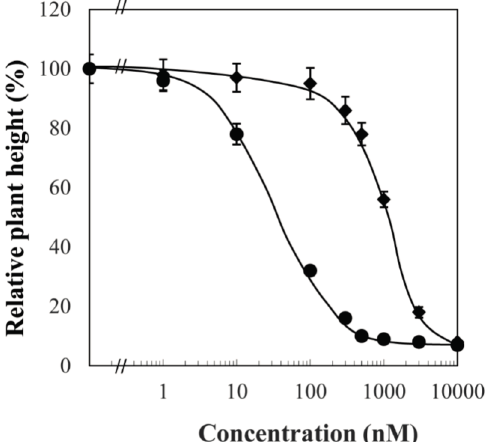
Figure 3. Dose-dependent effect of fenarimol and yucaizol on stem elongation of Arabidopsis seedlings grown in the dark. Filled cycle: yucaizol; filled diamond: fenarimol. Experiments were conducted under the conditions described in the text. Data are the means ± S.E. obtained from 8 to 10 plants. All of the experiments were duplicated to establish